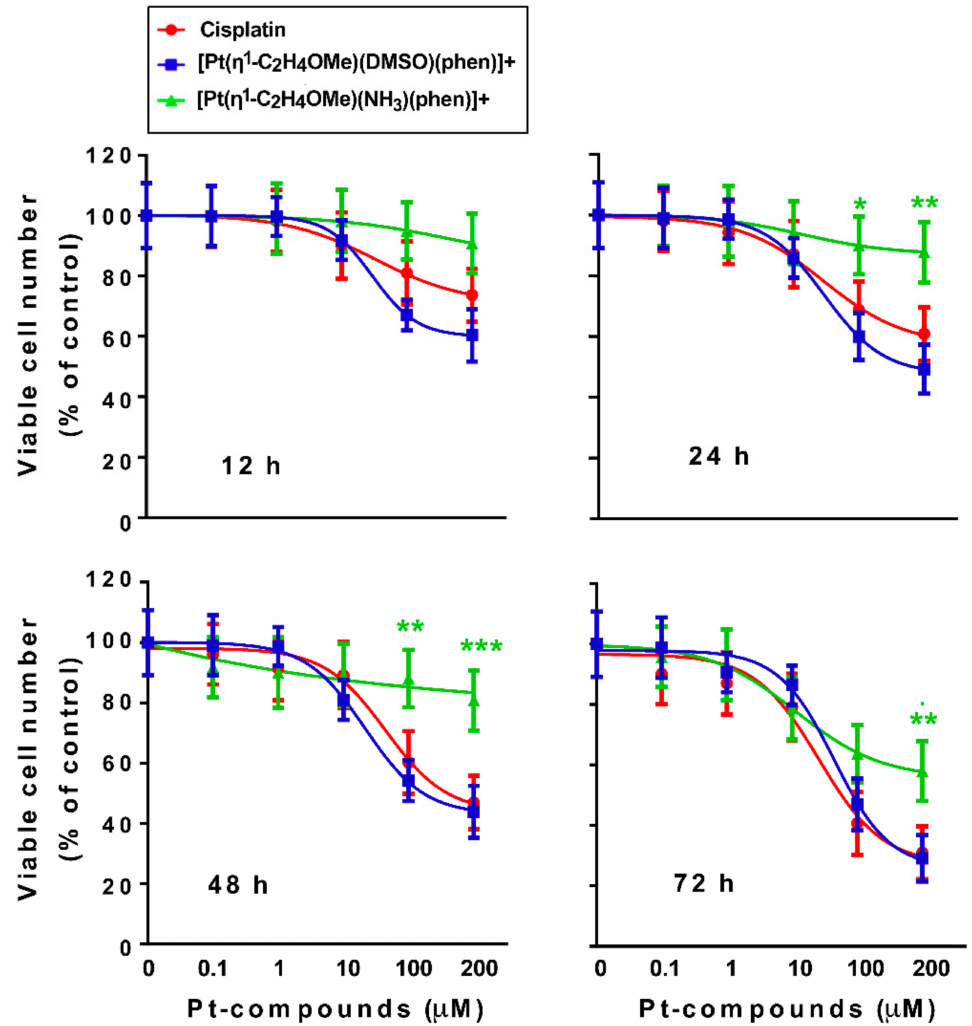
Figure 6. Cell viability assay after [Pt( η 1 -C 2 H 4 OMe)(DMSO)(phen)] + , [Pt( η 1 - C 2 H 4 OMe)(NH 3 )(phen)] + , and cisplatin treatments in Hep-G2 cell line. The viability of the hepatocellular cell line was evaluated after treatment with Pt compounds at different concentrations (0.1, 1, 10, 100, and 200 µ M) for 12, 24, 48, and 72 h. The data are means ± S.D. of three different experiments run in eight replicates and are presented as percent of control. Asterisks indicate values that are significantly different (* p < 0.05; ** p < 0.01; *** p < 0.001) from those of cisplatin at the same concentrations and time